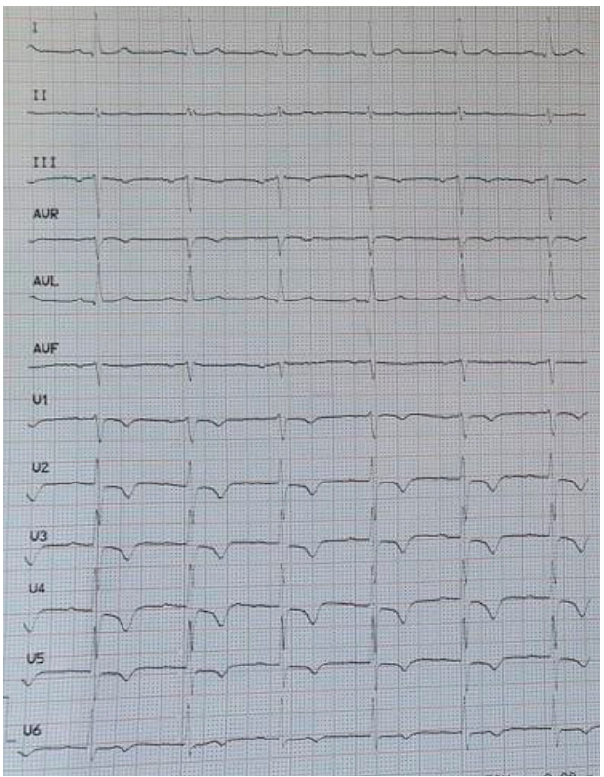
Figure 1. 12 lead electrocardiogram (ECG) showing T wave inversion in leads III and V1–V6.